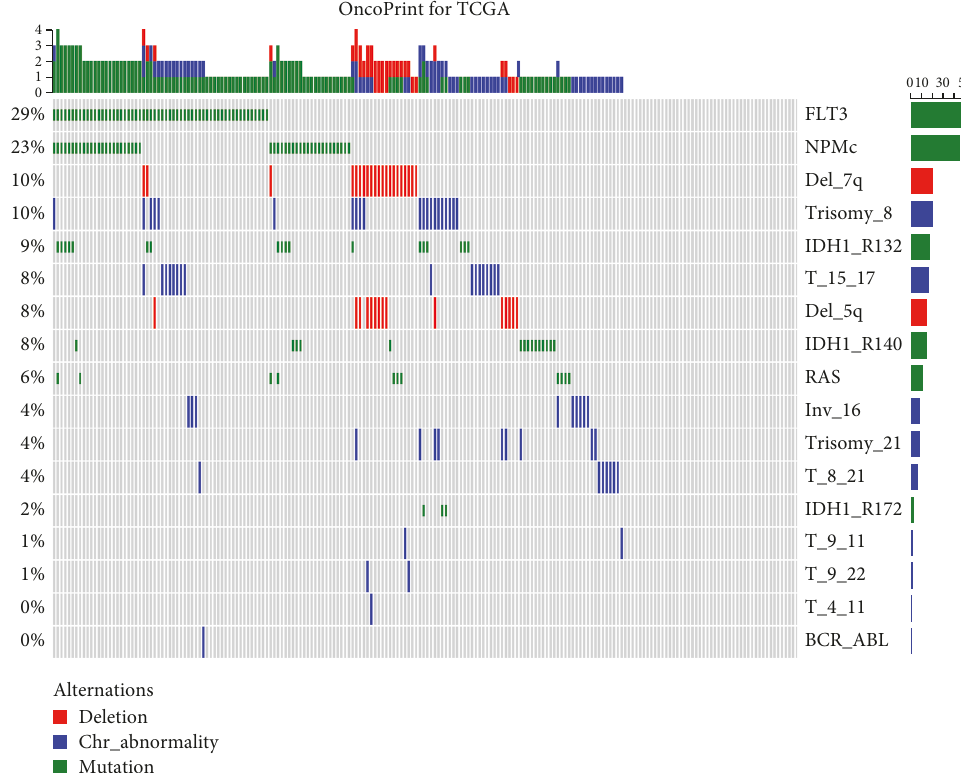
Figure 1: Distribution of genetic and cytogenetic abnormalities in AML. FLT3 and NPMc mutations are the most common abnormalities in AML patients. Many patients have multiple abnormalities. More than 50% of NPMc-positive patients are also FLT3 positive. Gray color represents either negative or